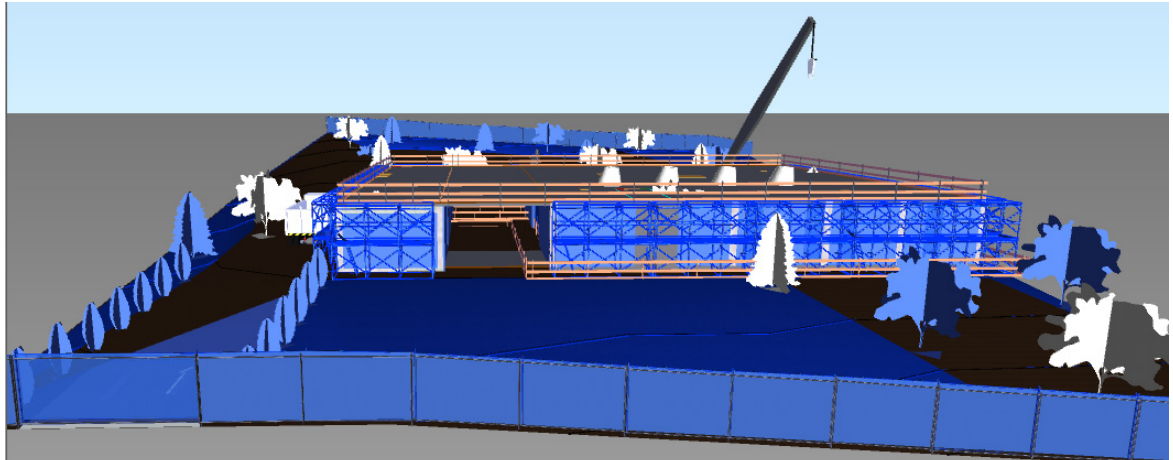
Figure 4. Federate model using Navisworks software.